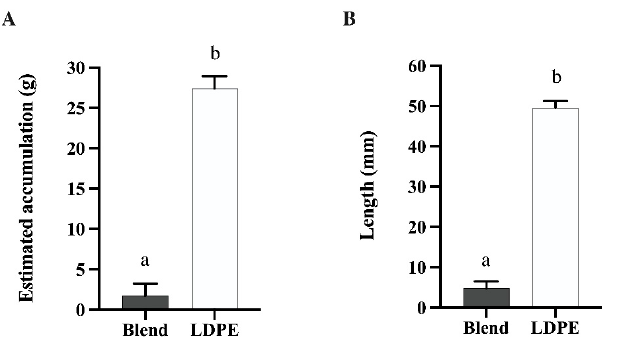
Figure 4. Characterization of polymer residues within rumen contents of Holstein bull calves given either Blend or LDPE treatment for 30 d, separated by ( A ) estimated total polymer accumulation and ( B ) average polymer length. For both parameters, treatment: p < 0.01. a,b Different letters indicate differences between treatments. Data are shown as least-squared means of treatments (LSM ± SEM).